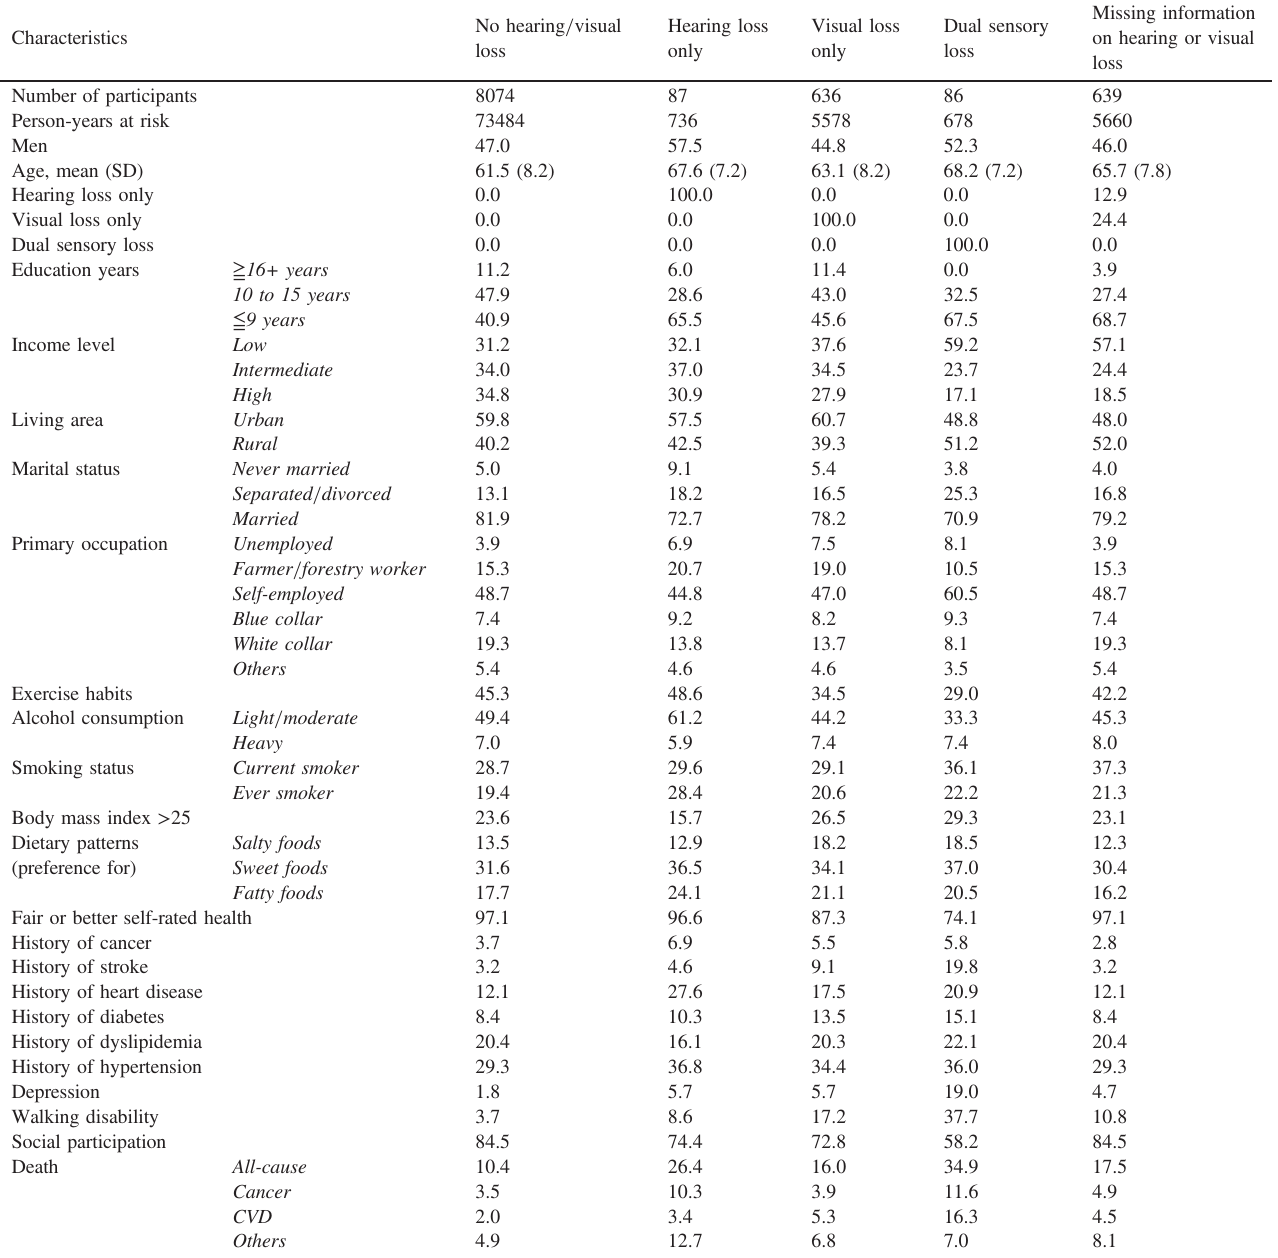
Missing information on hearing or visual